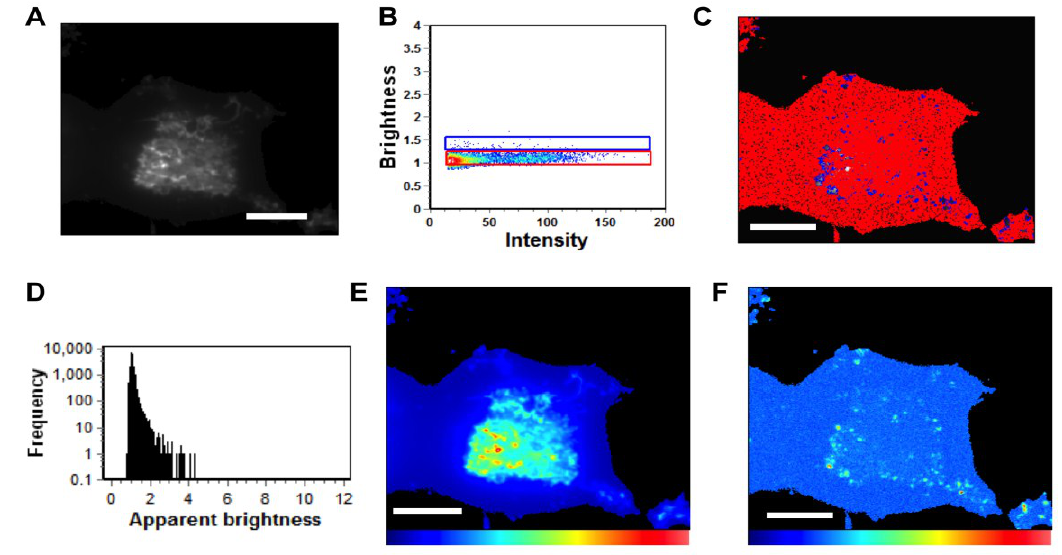
Figure 7. N&B Analysis of N130A. ( A ) TIRF microscopy was used to image EGFP-VP40-N130A expressed in HEK293 cells elucidating a low level of N130A enriched PM protrusions. ( B ) Brightness versus intensity plot displaying monomers and dimers (red box) and trimers and tetramers (blue box). Note that little to no hexamers were detected in the brightness versus intensity plot. ( C ) Brightness distribution of N130A at or on the PM displaying monomers and dimers (red) or trimers and tetramers (blue). ( D )